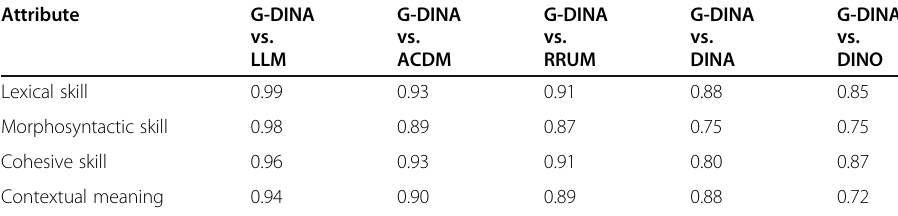
Table 6 Agreement of skill classification of the G-DINA and the constrained models Attribute G-DINA